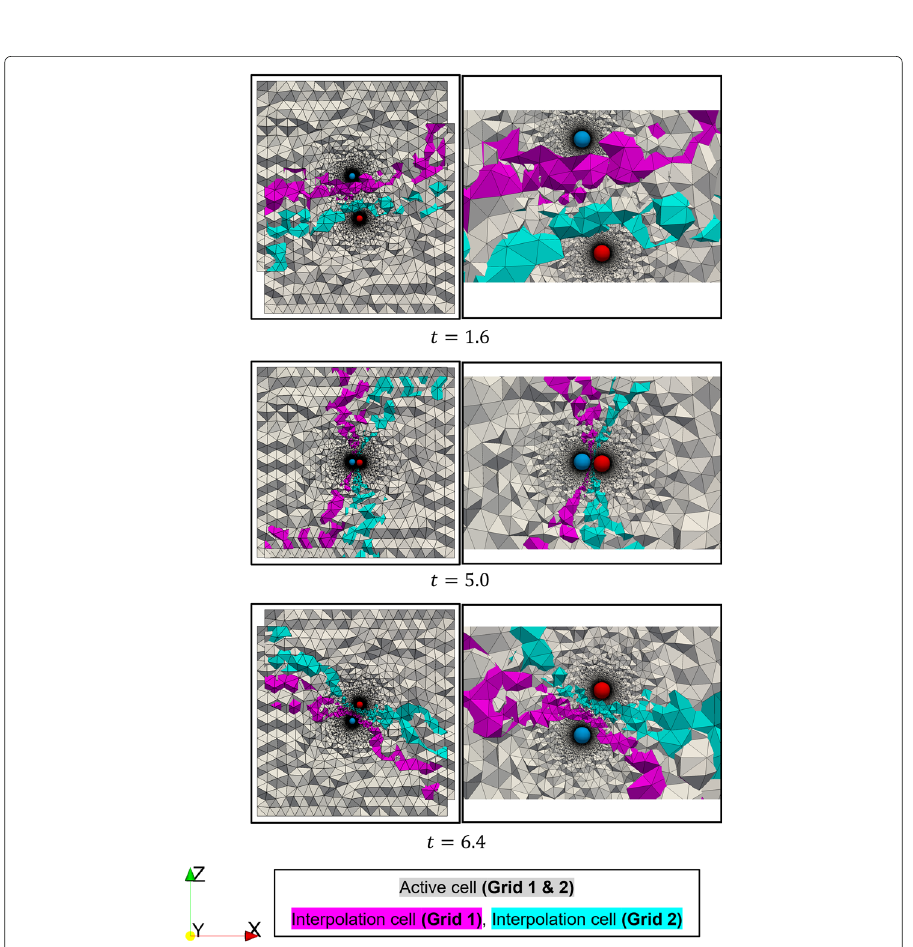
Fig. 12 Computational grids at each time step (crossing